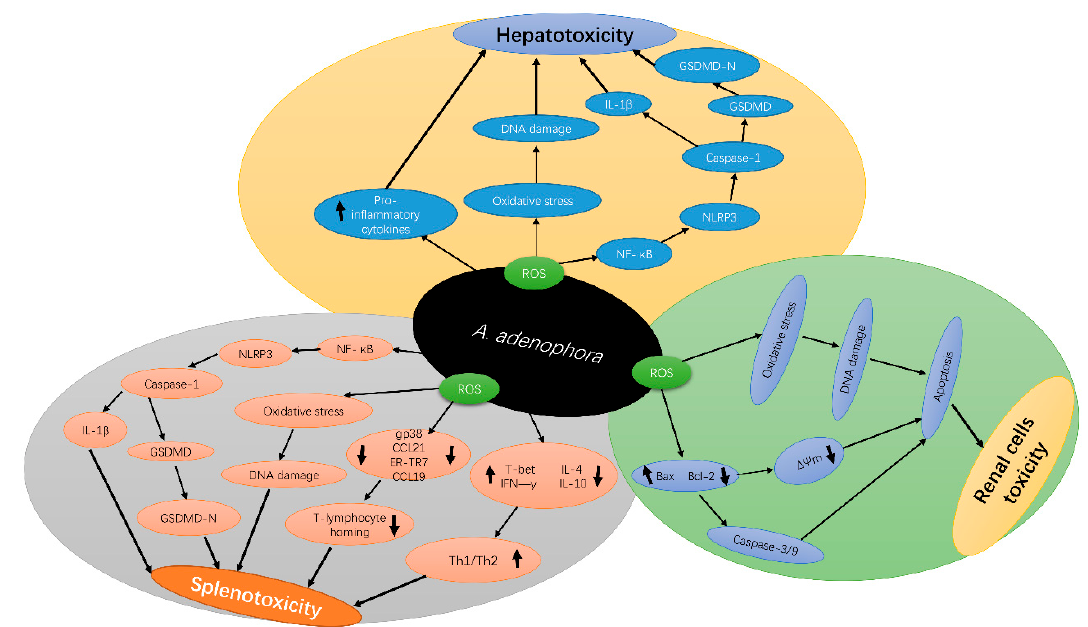
Figure 2. Schematic diagram of A. adenophora– induced toxicity in the liver, spleen and kidney and its underlying molecular mechanisms A. adenophora causes liver toxicity via the ROS apoptotic pathway, pro-inflammation mediated pathway, ROS-NLRP3-mediated pyroptosis pathway, and caspase-1-dependent pyroptosis pathway, A. adenophora causes spleen toxicity via ROS apoptotic pathway, ROS-NLRP3-mediated pyroptosis pathway, caspase-1-dependent pyroptosis pathway, destroying the Fibroblast reticulocyte (FCR) network and elevating Th1/Th2 ratio, Finally A. adenophora causes toxicity of the kidney via ROS apoptosis pathway, caspase 3/9 mediated pathway and mitochondria dysfunction pathway. IL-1 β —Interleukin 1-beta, ROS—reactive oxygen species, GSDMD—gasdermin D, NLRP3—NOD-, LRR- and pyrin domain-containing protein 3,